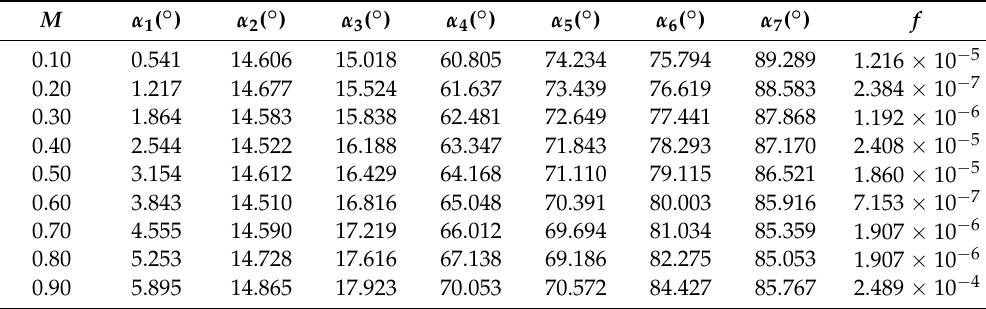
Table 7. SHEM Angles Found by Hardware Co-simulation.